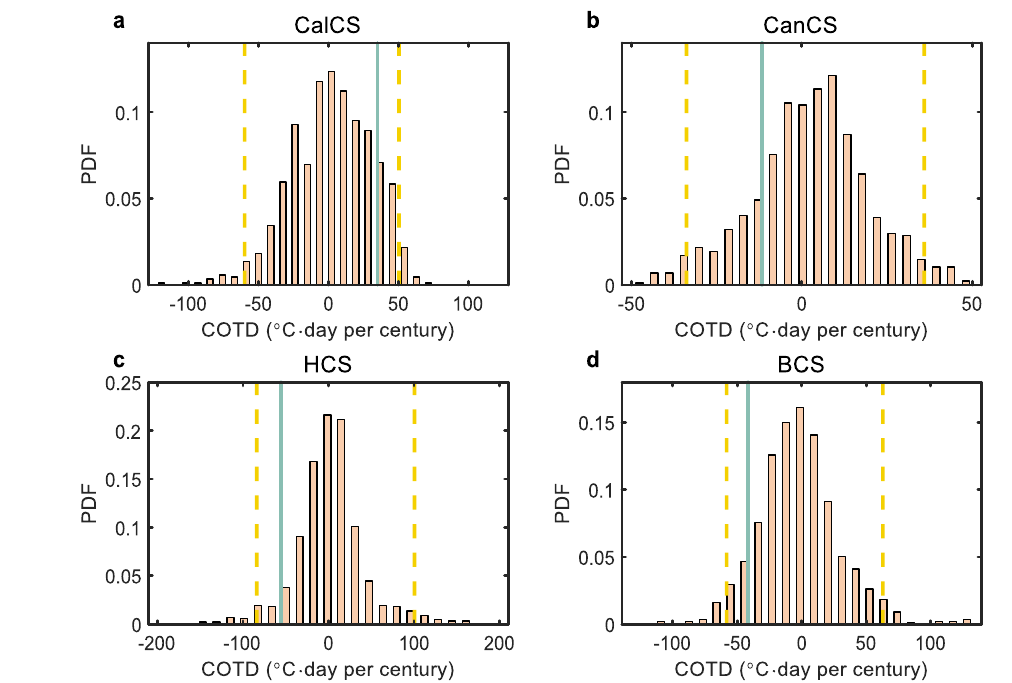
Fig. 5 | Natural multi-decadal variability of marine heatwave (MHW) stress in theeasternboundaryupwellingsystems(EBUSs)simulatedbyhigh-resolution coupled global climate models (CGCMs). The probability density function (PDF) of the 40-year rolling coastal and oceanic trend difference (COTD) of MHW stress averagedover California currentsystem(CalCS, a ),Canarycurrentsystem(CanCS,